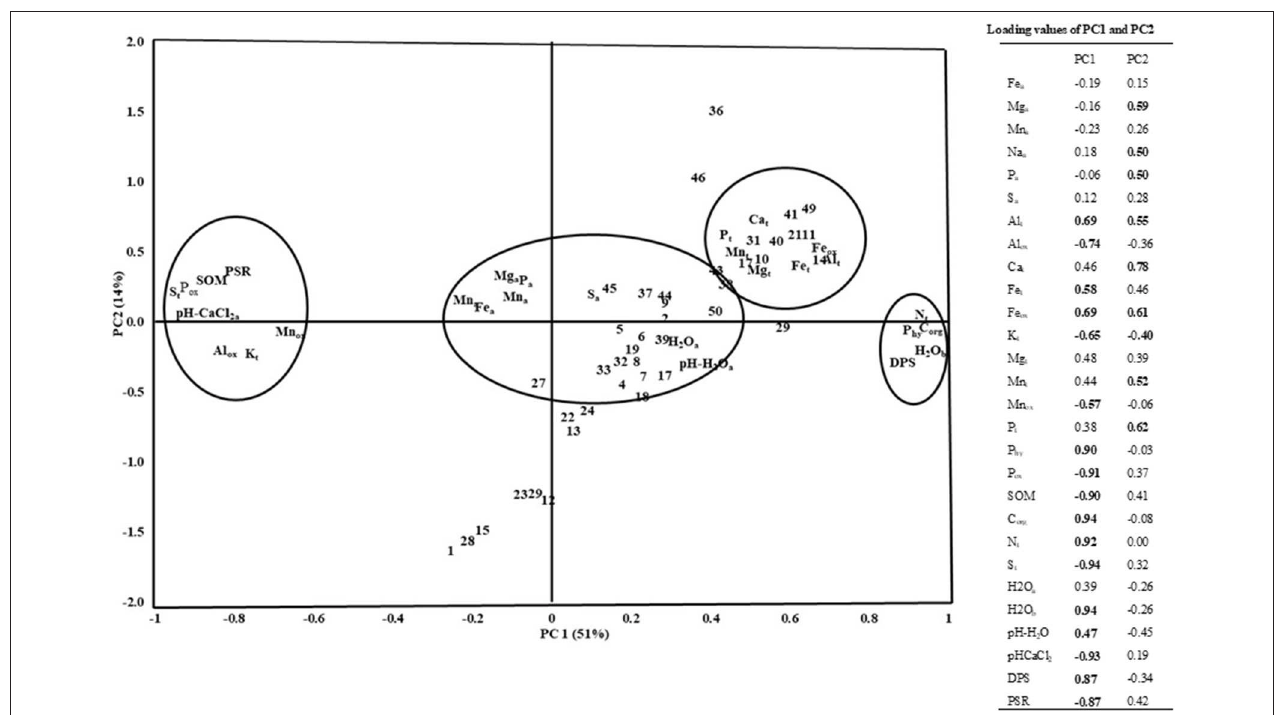
FIGURE 3 | PCA of soil chemical properties in a rewetted peatland. Subscript: “a”: plant available elements, “t”: total element, ox, oxalate extracted elements; Phy, hypobromide extracted P; H2Oa, water content of 0–10cm soil depth; H2Ob, water content of 10–20cm soil depth; DPS, degree of P saturation; PSR, P saturation ratio, numbers in the Figure stand for the number of sampling grid cells.